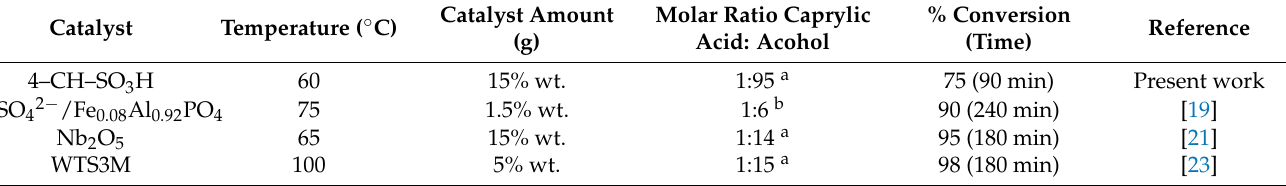
Table 2. Comparison of caprylic acid conversion with reported catalyst.